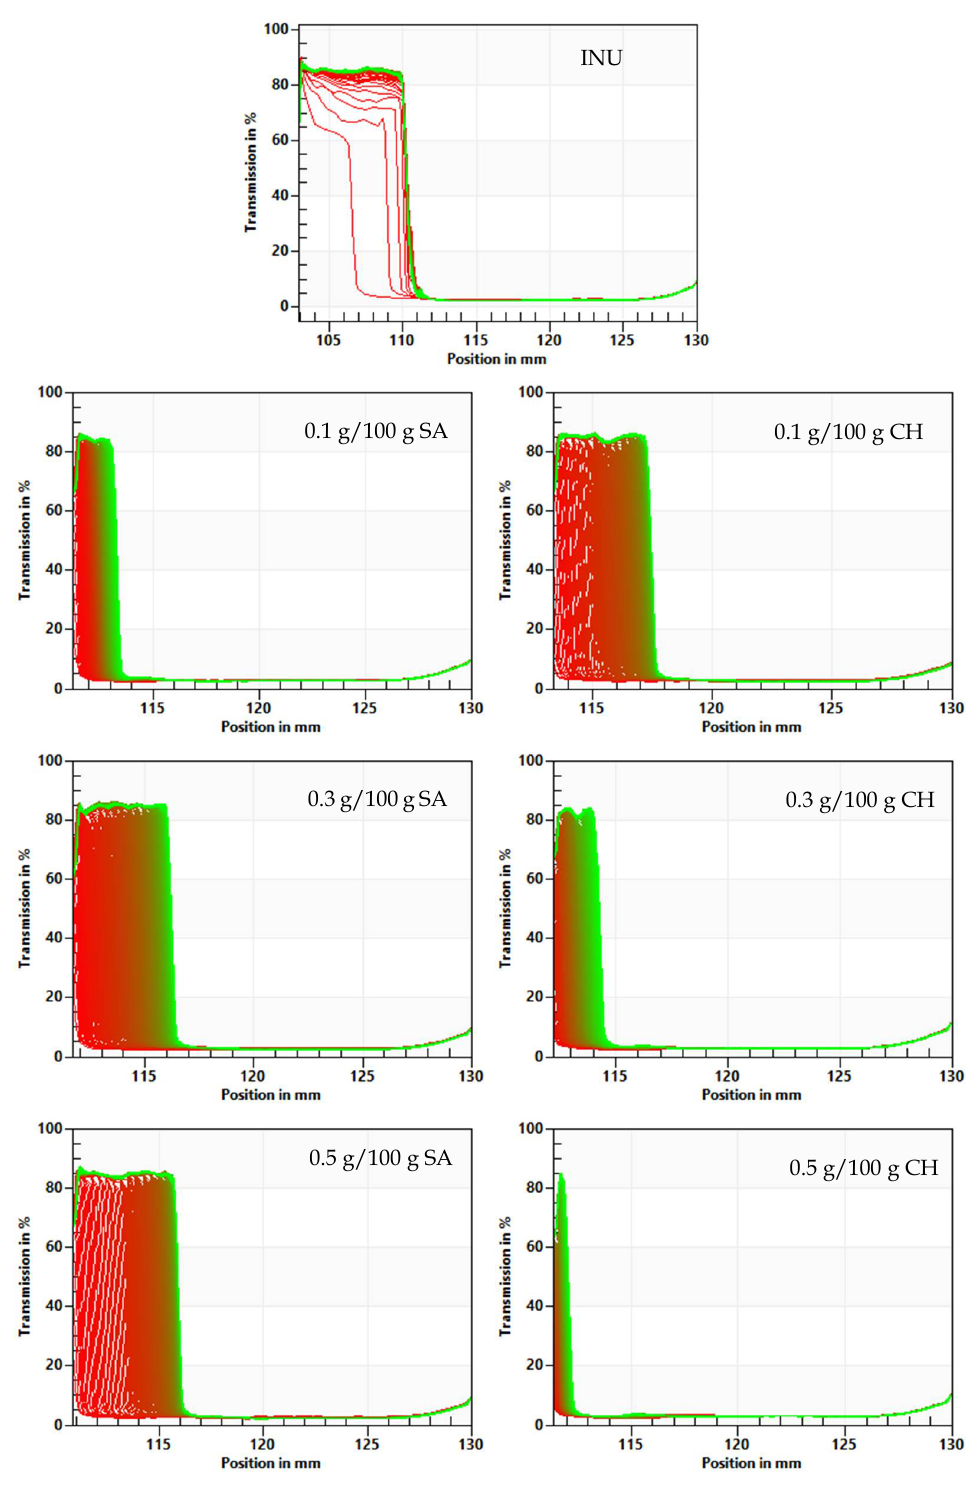
Figure 3. Influence of sodium alginate (SA) and chitosan (CH) addition on the transmission profile “fingerprints” of inulin hydrogels.